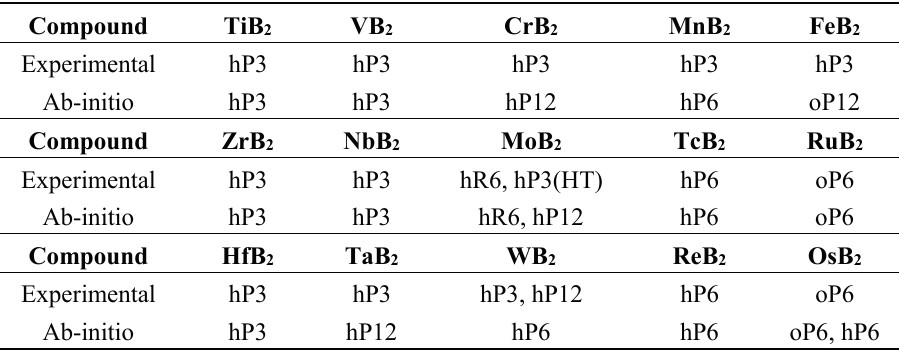
Table 2. Structure of the early transition metal diborides observed experimentally [13] and calculated in the present work as being the ground state or only slightly metastable at zero temperature and